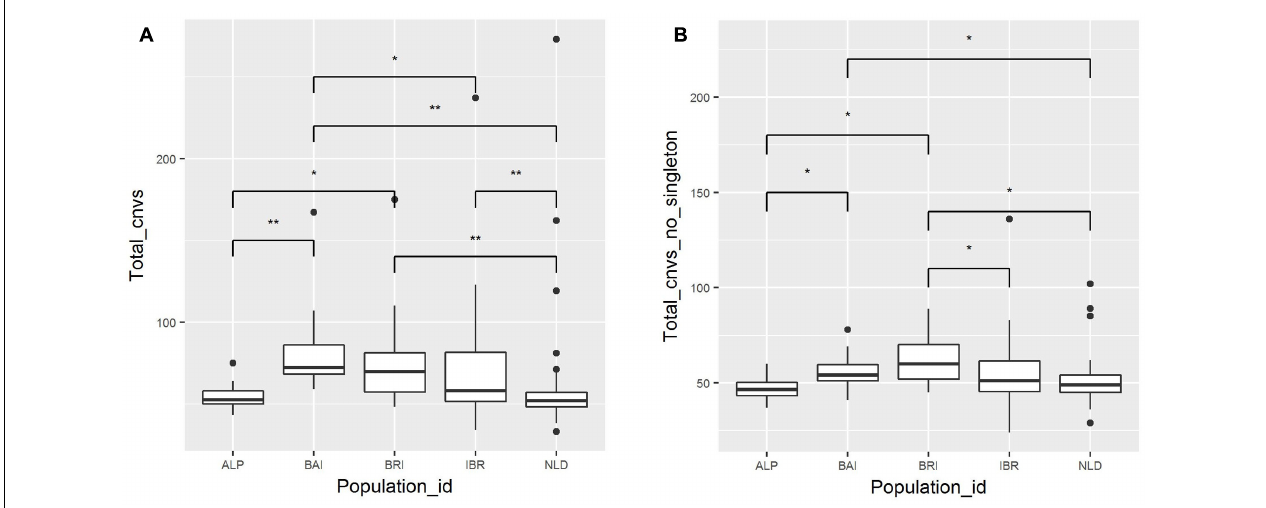
FIGURE 1 | Number of detected CNVs per sample. Samples are categorized based on their origins. The median of the population is indicated by central line in a box, while the black dots represents outliers. Connecting bar above box plots between pair of populations displays significant P -values. “ ∗ ” Indicates P < 0.05 and “ ∗∗ ” indicates P < 0.01. (A) Total CNV counts with singleton. (B) Total CNV abundance excluding singleton.